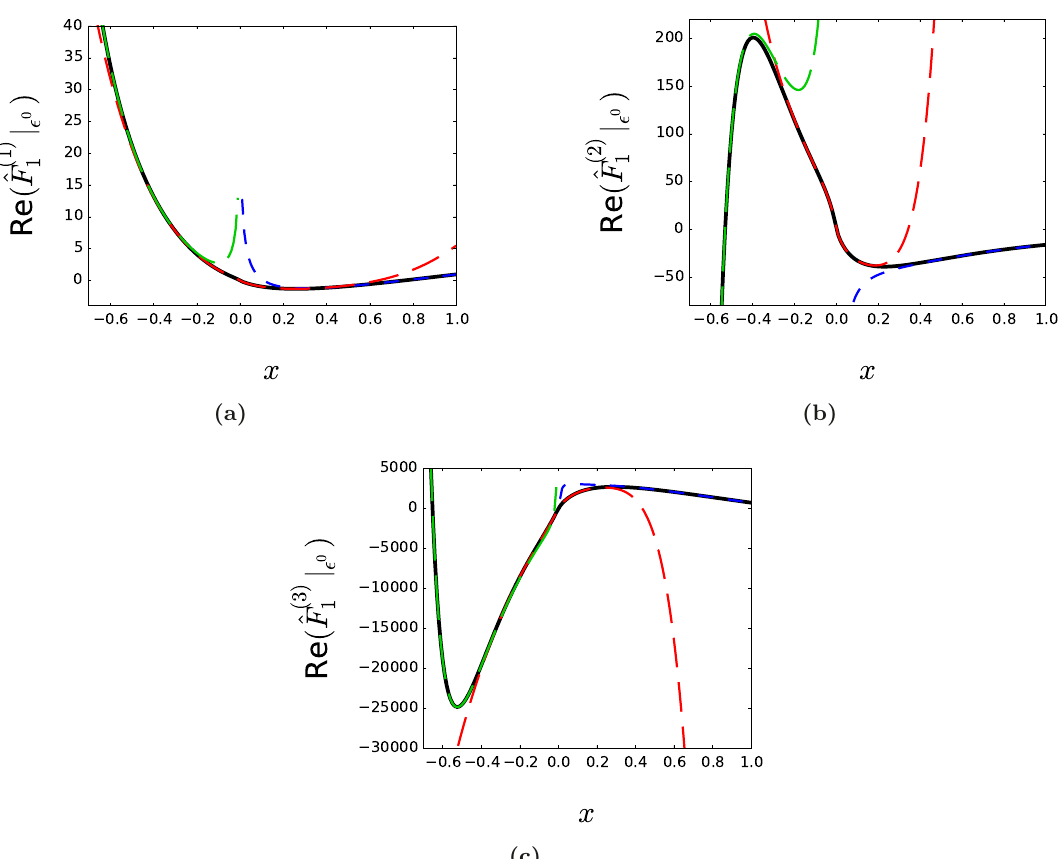
Figure 6. Panels (a), (b) and (c) show the real part of the ǫ 0 term of ˆ F 1 ( q 2 ) at one-, two- and three-loop order, respectively. The solid (black) lines correspond to the exact result and the dashed lines to